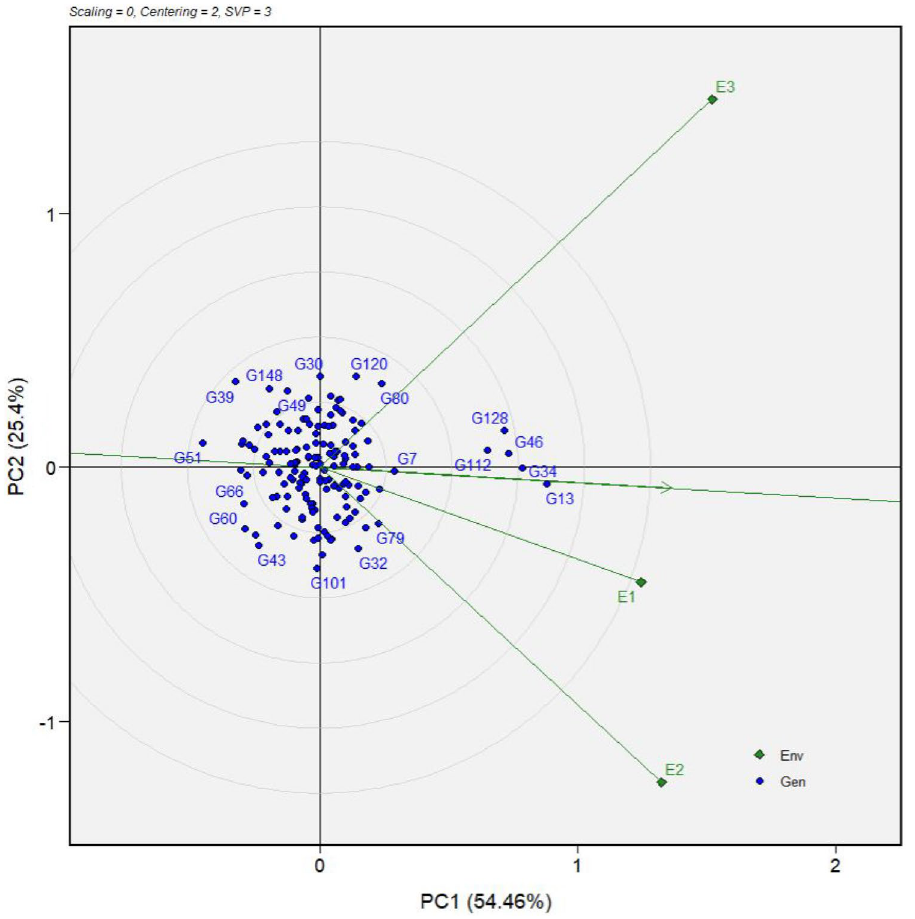
Figure 3. The average-environment coordinate (AEC) view of the genotype main effects plus genotype × environment interaction (GGE) biplot showing the discriminating ability and representativeness of the three test environments based on the sensory mealiness data of 150 cassava genotypes. Environment names are coded as: E1, Igbariam; E2, Otobi; E3, Umudike. G1-G150 are genotypes defined in Supplementary Table S1.